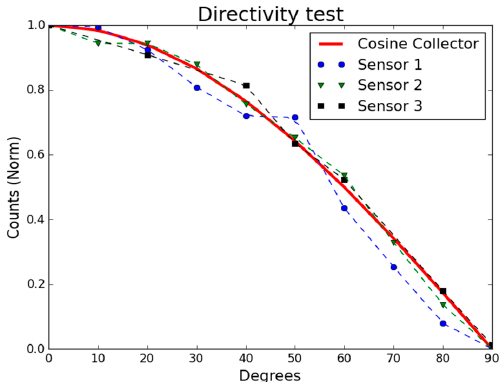
Figure 10. Comparison of measurements obtained with three different TLS230RP sensors encapsulated in Synolite and the ideal response of a cosine collector.